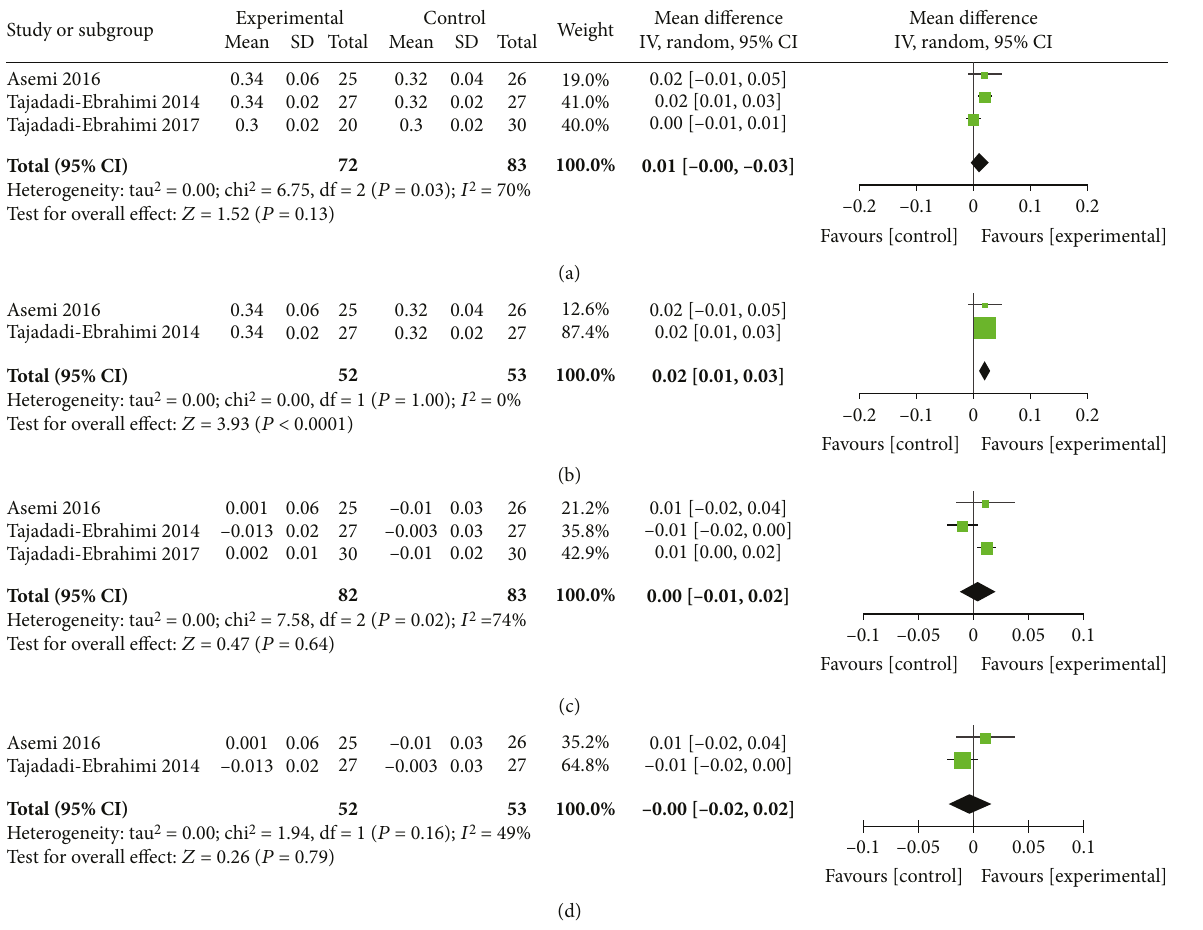
Figure 8: Findings of a meta-analysis of studies with continuation data on improvement in QUICKI for ITC vs. control groups, with estimated MD and 95% CI. (a) Postintervention data of QUICKI, (c) reduction data of QUICKI, and (b, d) subgroup analysis according to the baseline BMI